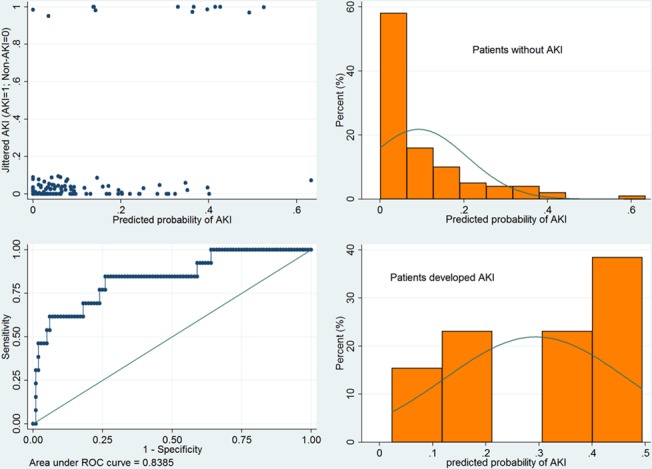
Graphical presentation of model discrimination.Jittered plot shows that non-AKI dots are mostly clustered to the left side and AKI dots are mostly clustered to the right side. ROC curve showed good discriminating power of the model with an area under ROC of 0.84. The histogram shows the distribution of predicted risk score for AKI stratified by observed AKI and non-AKI. In non-AKI group, the distribution of predicted AKI probability skewed to the right; while in AKI group, the distribution of predicted AKI probability skewed to the left. P = 0.2707 for Hosmer-Lemeshow goodness-of-fit test.